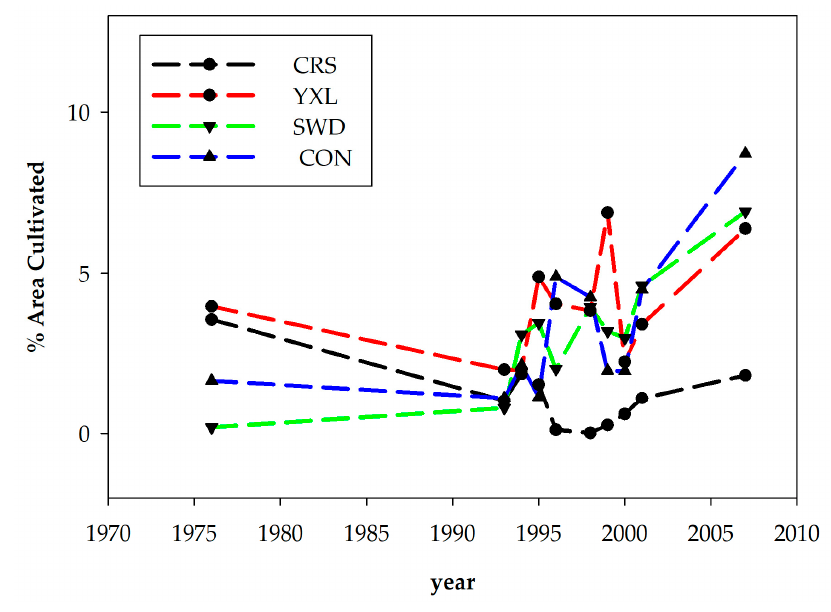
Figure 3. Percent of total land area under cultivation within the four study catchments, during the time period 1976 to 2007 (CRS = Crique Sarco Creek; YXL = Yax Cal Creek; SWD = Sunday Wood Creek; CON = Conejo